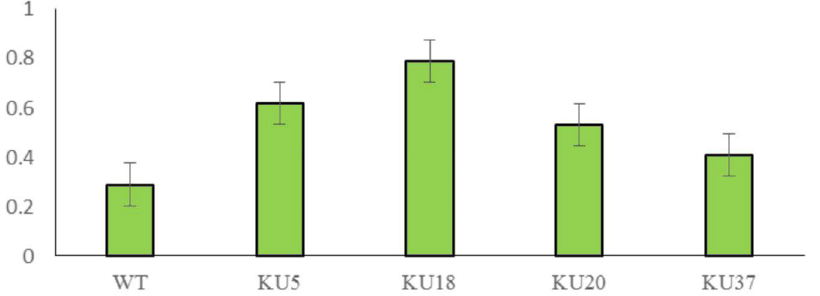
Fig. 1. Mutant screening and biomass yield of D. salina of each strain cultured in 1.5 M NaCl modified Johnson’s medium under light intensity 200 mmol photons m -2 ·s -1